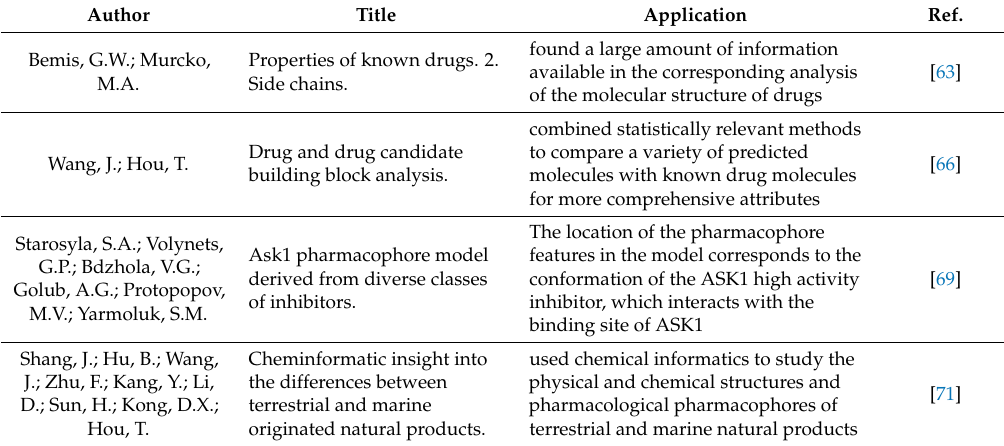
Table 2. The application examples of pharmacophore